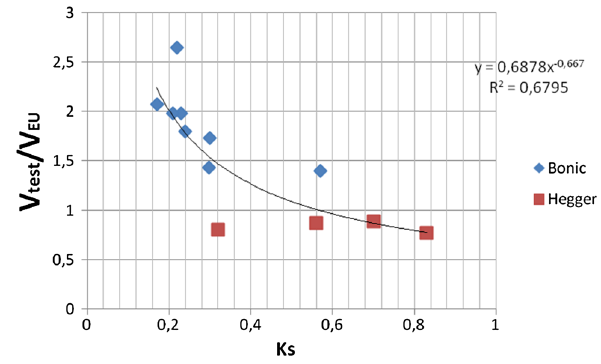
Fig. 22 Comparison of results of the punching tests and stiffness coefficient k s